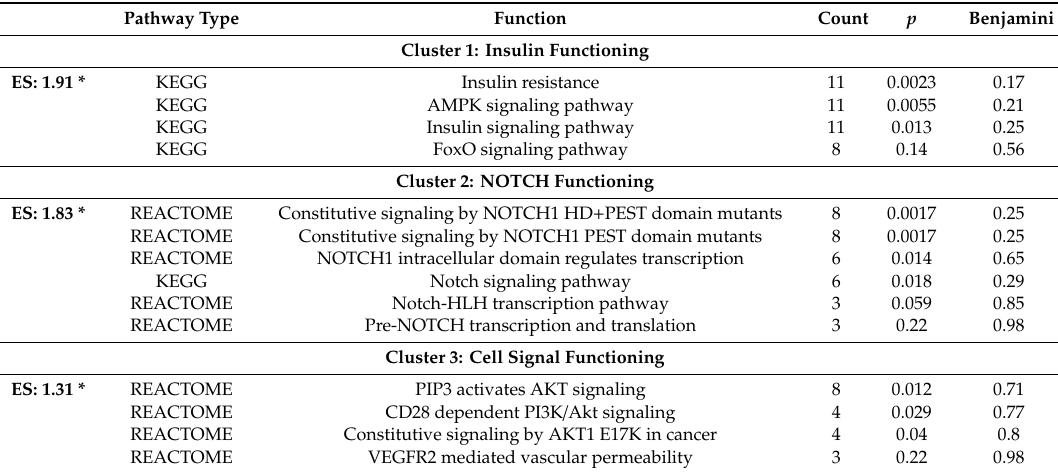
Table 5. Gene functional clusters of the 1000 highest ranked probes from linear regression analysis associated with membership of the ROLO intervention or control